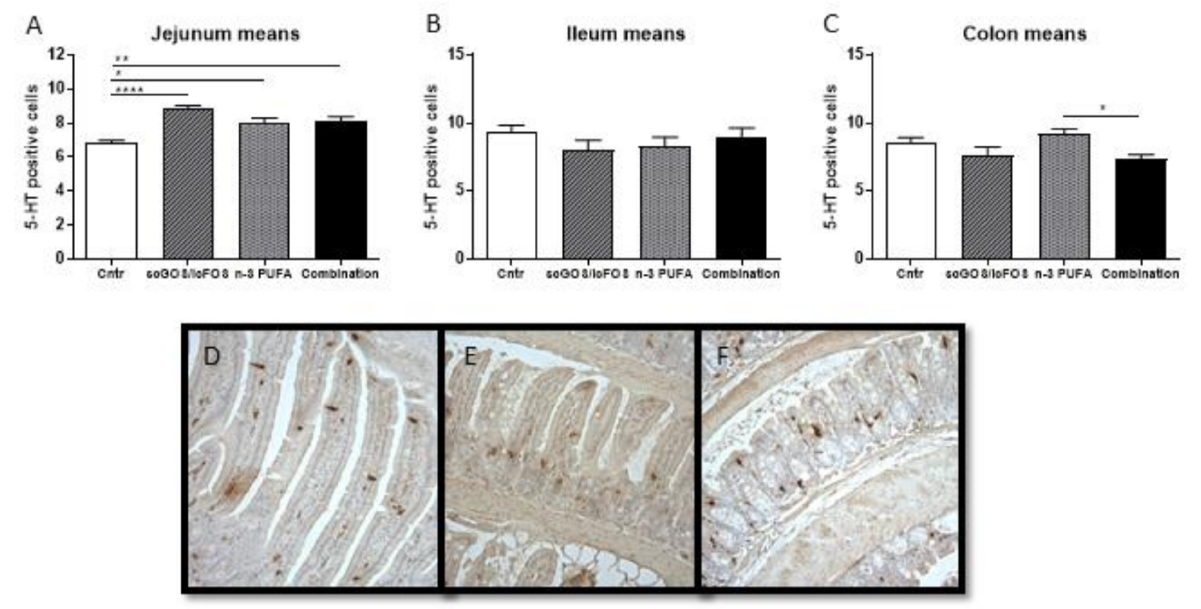
Figure 6. Serotonin-producing cells in the jejunum, ileum and colon. ( A ) In the jejunum, the number of serotonin-producing cells increased in the scGOS:lcFOS, n-3 PUFA and the combination diet groups compared to control. ( B ) In the ileum, the diets did not affect the serotonin-producing cells. ( C ) In the colon, the number of serotonin-producing cells was significantly decreased in the combination diet group compared to the n-3 PUFA group. ( D – F ) Representative pictures (control group) of the jejunum ( D ), ileum ( E ) and colon ( F ). ( A – C ): Data shown as the mean +/ − SEM. Analysed by one-way ANOVA and Sidak’s multiple comparisons post hoc test. * p < 0.05, ** p < 0.01, **** p < 0.0001. n = 6 mice per